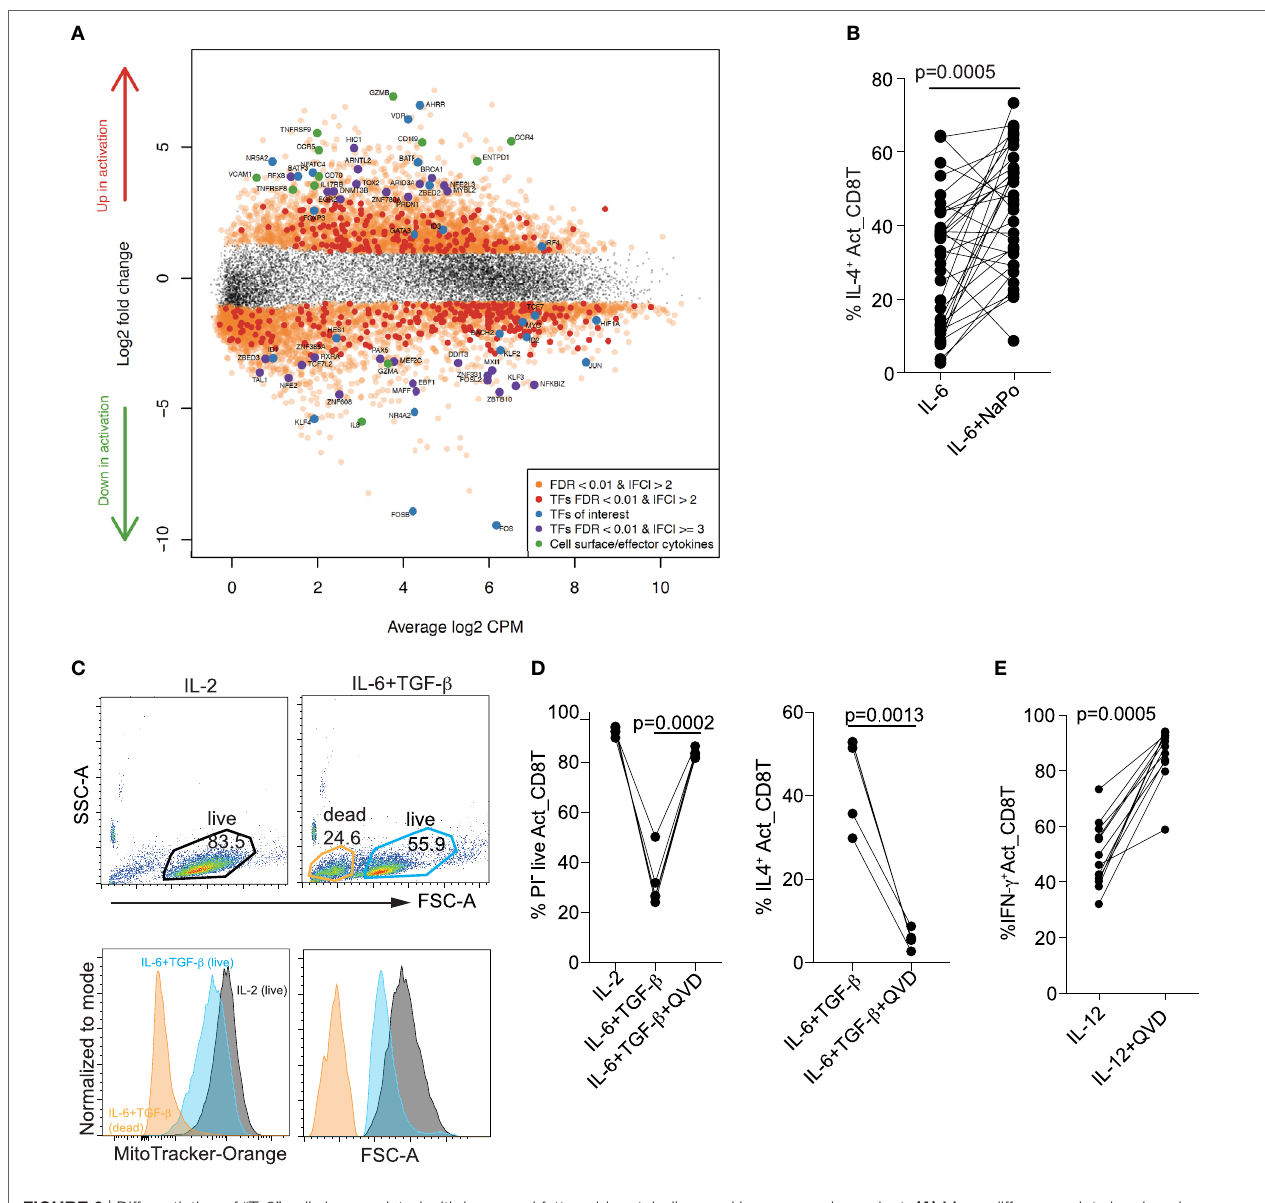
FigUre 6 | Differentiation of “T C 2” cells is associated with increased fatty acid metabolism and is caspase dependent. (a) Mean-difference plot showing changes in gene expression associated with “T C 2” differentiation. (B) IL-4 expression is increased with supplementation of sodium propionate (NaPo) (right). (c) Decreased mitochondrial membrane potential (MitoTracker-Orange stain) and cellular size in live “T C 2” compared with T C 1 cells. Data are representative of n > 10 donors, all with similar results. (D) Prevention of cell death and IL-4 expression at day 5 by the caspase inhibitor QVD-Oph added at day 0 and supplemented at day 3. (e) Enhancement of IFN- γ expression at day 5 by the caspase inhibitor QVD-Oph added at day 0 and supplemented at day 3. P -values were calculated by Wilcoxon matched-pairs signed rank